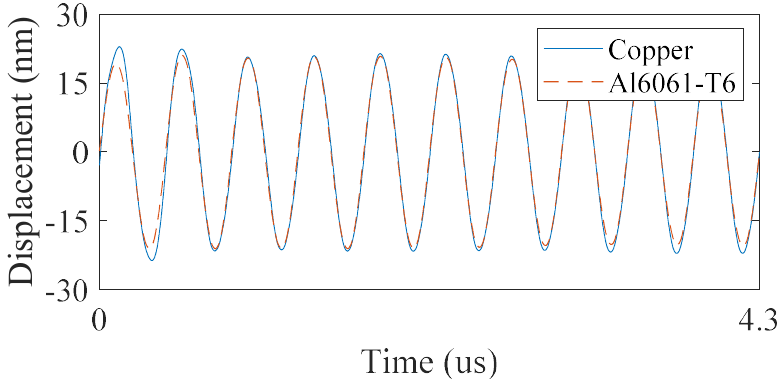
Figure 6. Typical ultrasonic signals in time-domain for copper (blue solid line) and Al6061-T6 (brown dotted line) specimens. The two signals aligned with the time axis overlap each other.